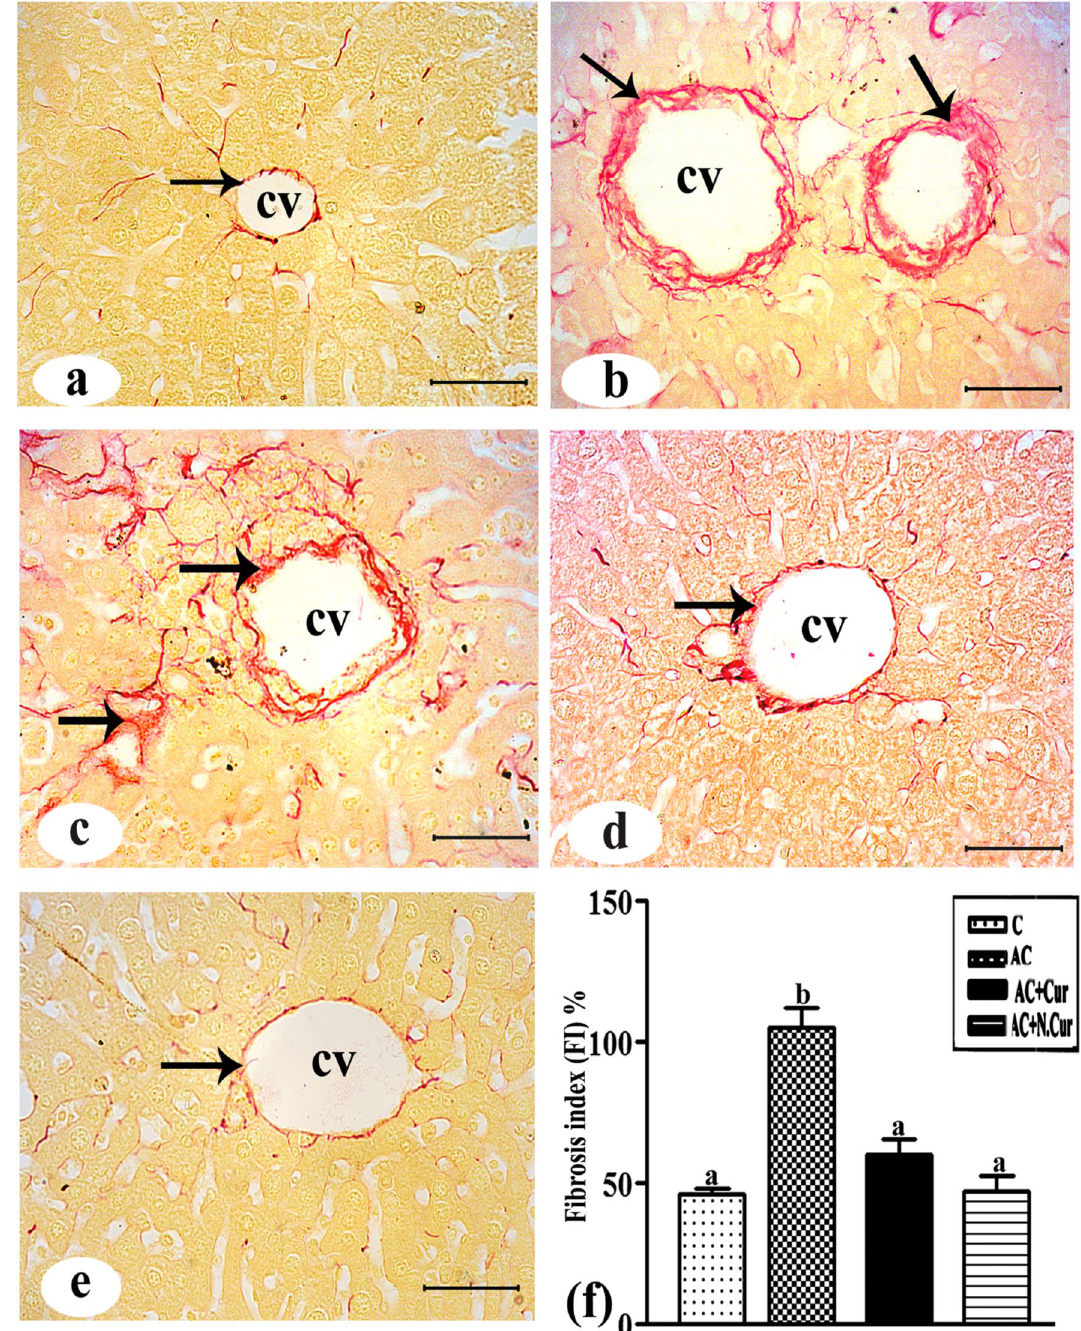
Figure 9. (a ) High magnification image of liver tissue from a control male mouse showing few collagenous fibers around hepatocytes (arrow) or the central vein (cv). (b and c) Liver tissue from an AC group mouse showed large amounts of collagenous fibers (arrows) among hepatocytes and around the cv. (d) Liver tissues from AC + Cur and (e) AC + NCur group mice showing minimal amounts of collagenous fibers (arrow) around the cv (picrosirrus stain Bar = 50 μm). (f) Percentage liver fibrosis scores. Columns with different letters are significantly different ( p <